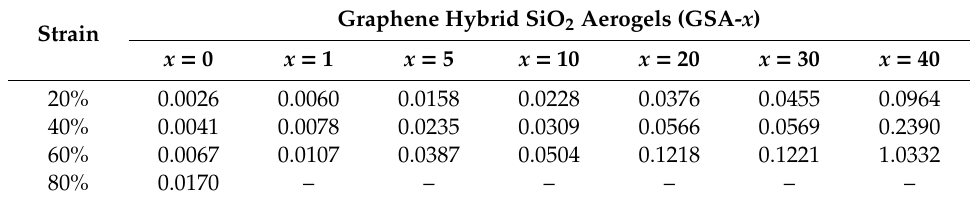
Table 2. Deformation intensification of compressive strength under di ff erent strains (MPa).